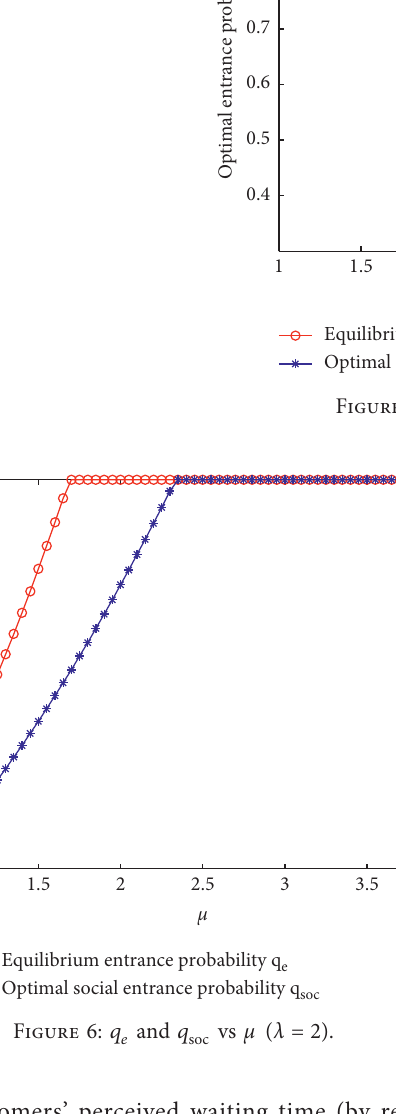
q vs μ ( λ � 2 ) e and soc